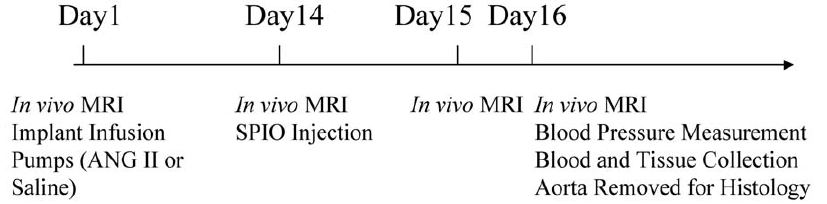
Figure 1. Experimental study design. Saline or ANG II were administrated via an osmotic minipump at day 1. Resovist (1 mmol/kg iron) was administered on Day 14 following ANG II infusion. Animals were imaged on Days 1, 14, 15 and 16 individually. Blood pressure was assessed on Day 16 prior to sacrifice. Tissue and blood were harvested on the completion of imaging on Day 16.